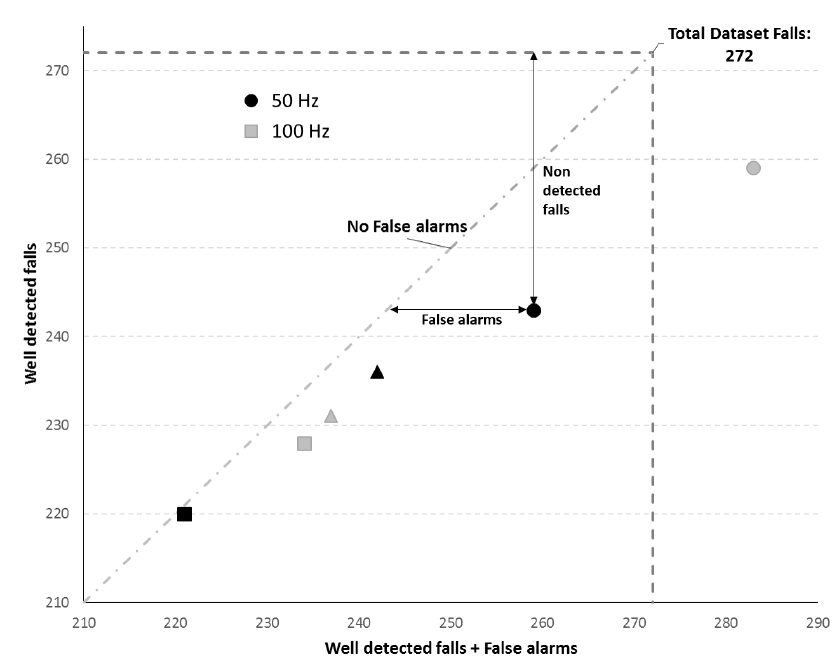
Figure 3. Total Operating Characteristic (TOC) curve with the results of the algorithm on DS-2 using each set of thresholds chosen for each frequency. Legend: Squares—Low sensitivity levels; Triangles—Medium sensitivity levels; Circles—High sensitivity levels; Black marks—50 Hz; Grey marks—100 Hz.